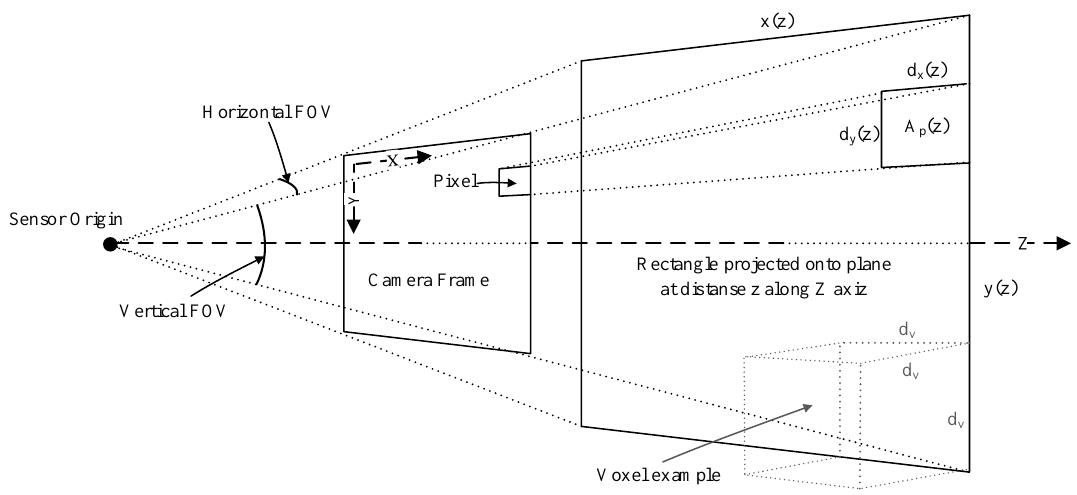
Figure 4. Schematic view of a sensor’s field of view when projected onto a plane perpendicular to its direction of